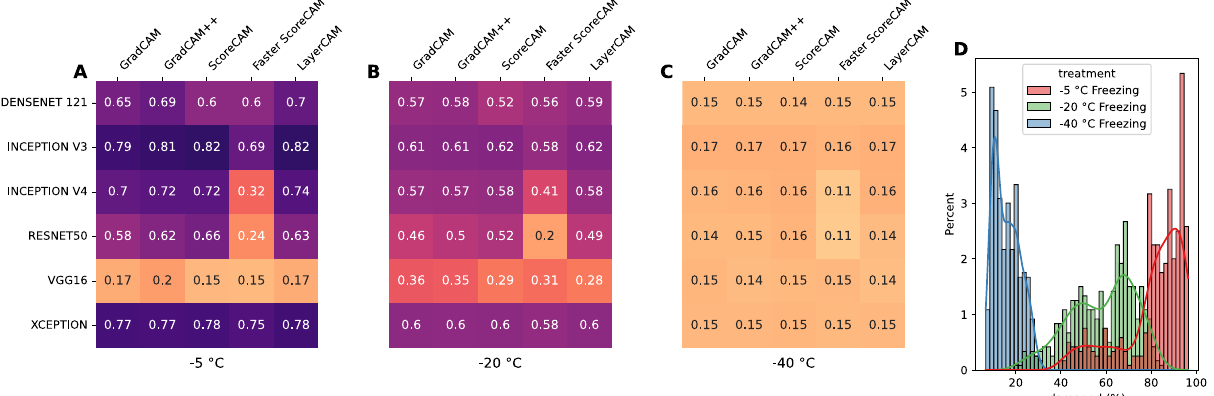
Figure 3. ( A – C ) Mean intersection over union (mIoU) between CAM images ( t CAM = 0.5 ) and supervised